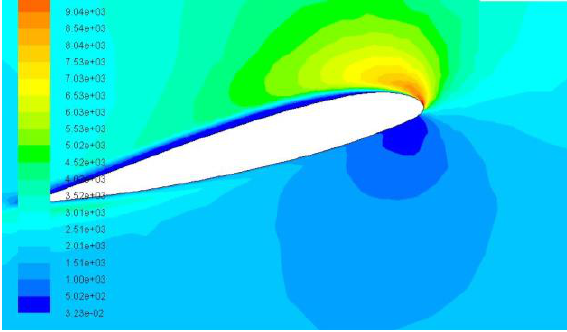
Fig. 10. Results of the CFD analysis of the blade profile section